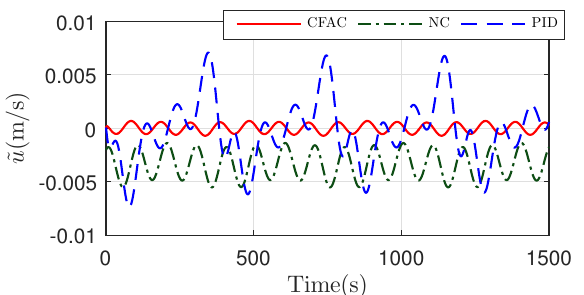
Figure 22. Velocity tracking performance in floating motion with a constant velocity and variable pitch angle command.